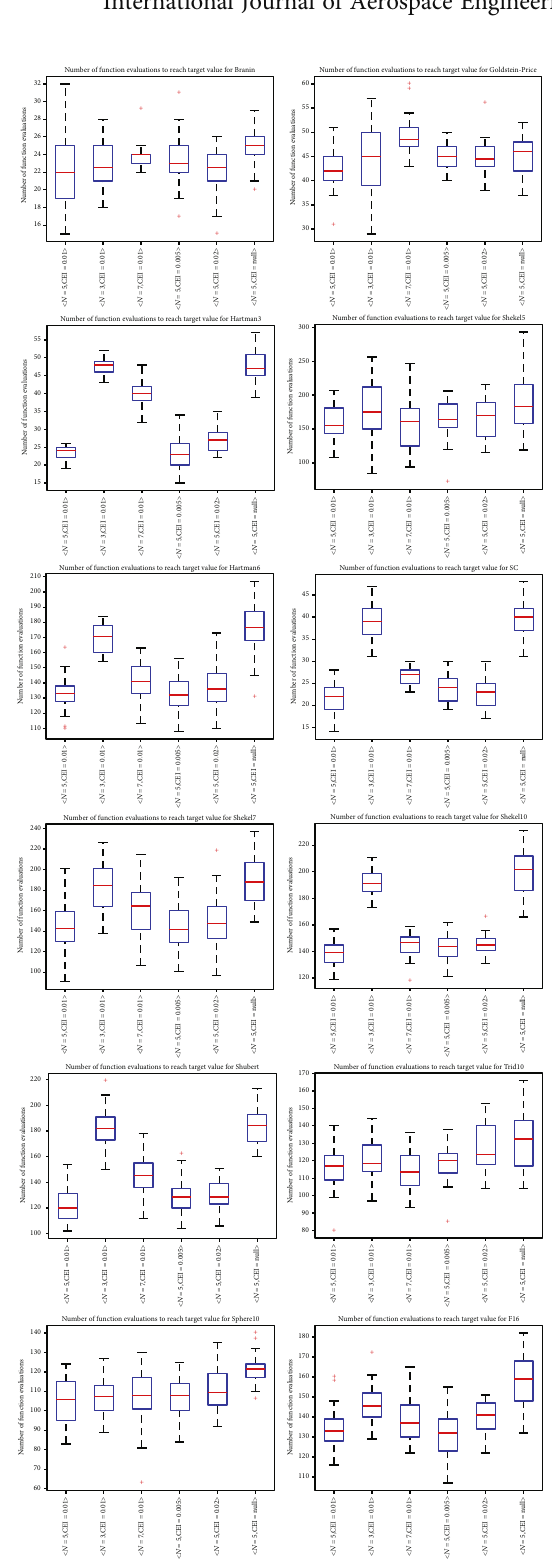
Figure 12: Box plot of the number of function evaluations to get within 1% of the target